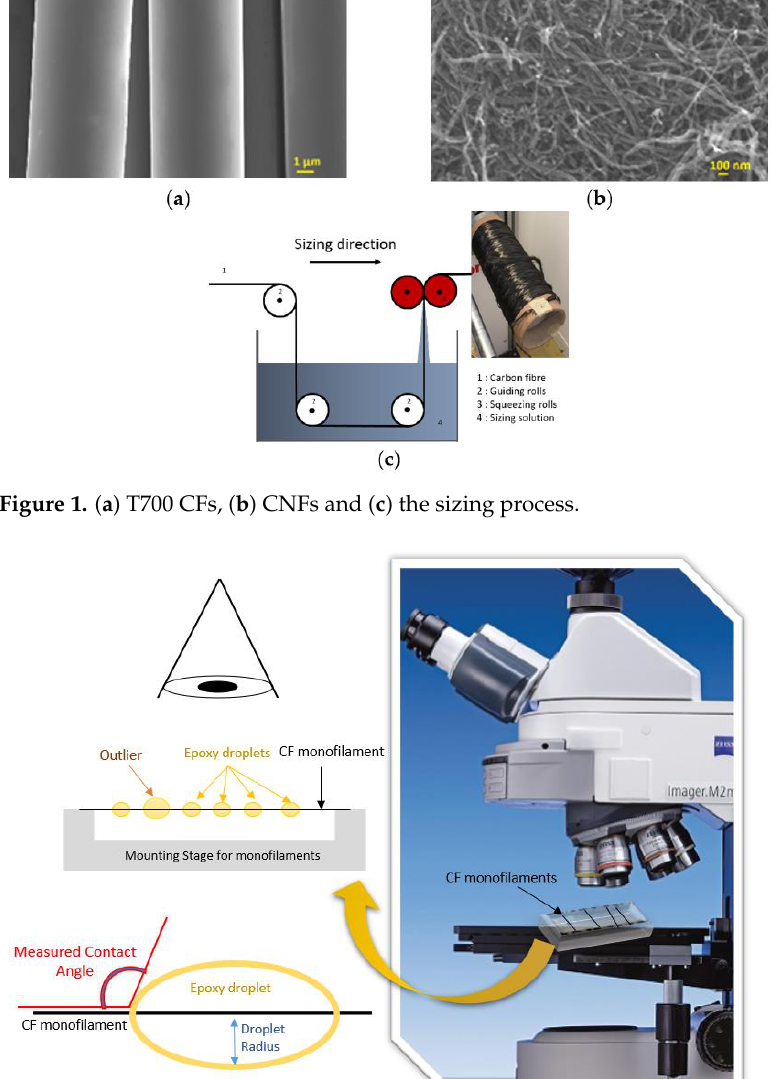
Table 1. Detail of sizing of T700 CFs with CNFs and CF volume fraction of the respective CFRPs. Code